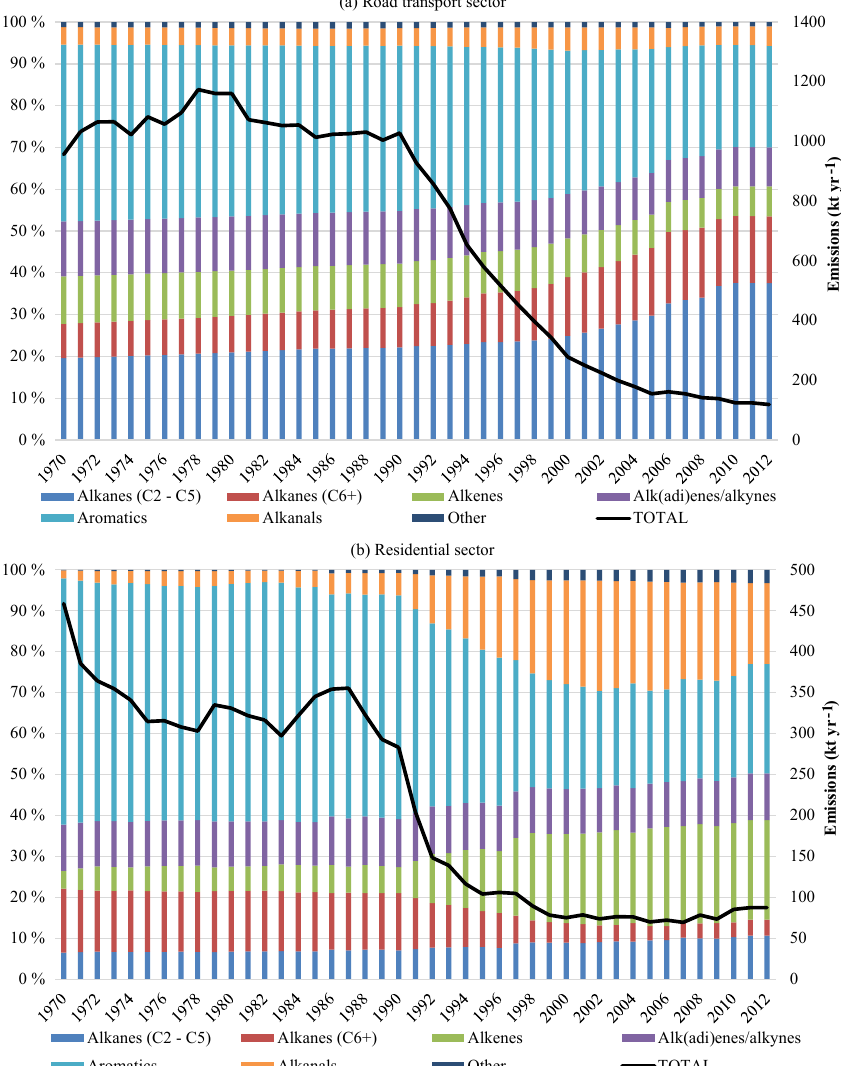
Figure 5. Total NMVOC emissions and their speciation for (a) the road transport sector and (b) the residential sector in Germany during